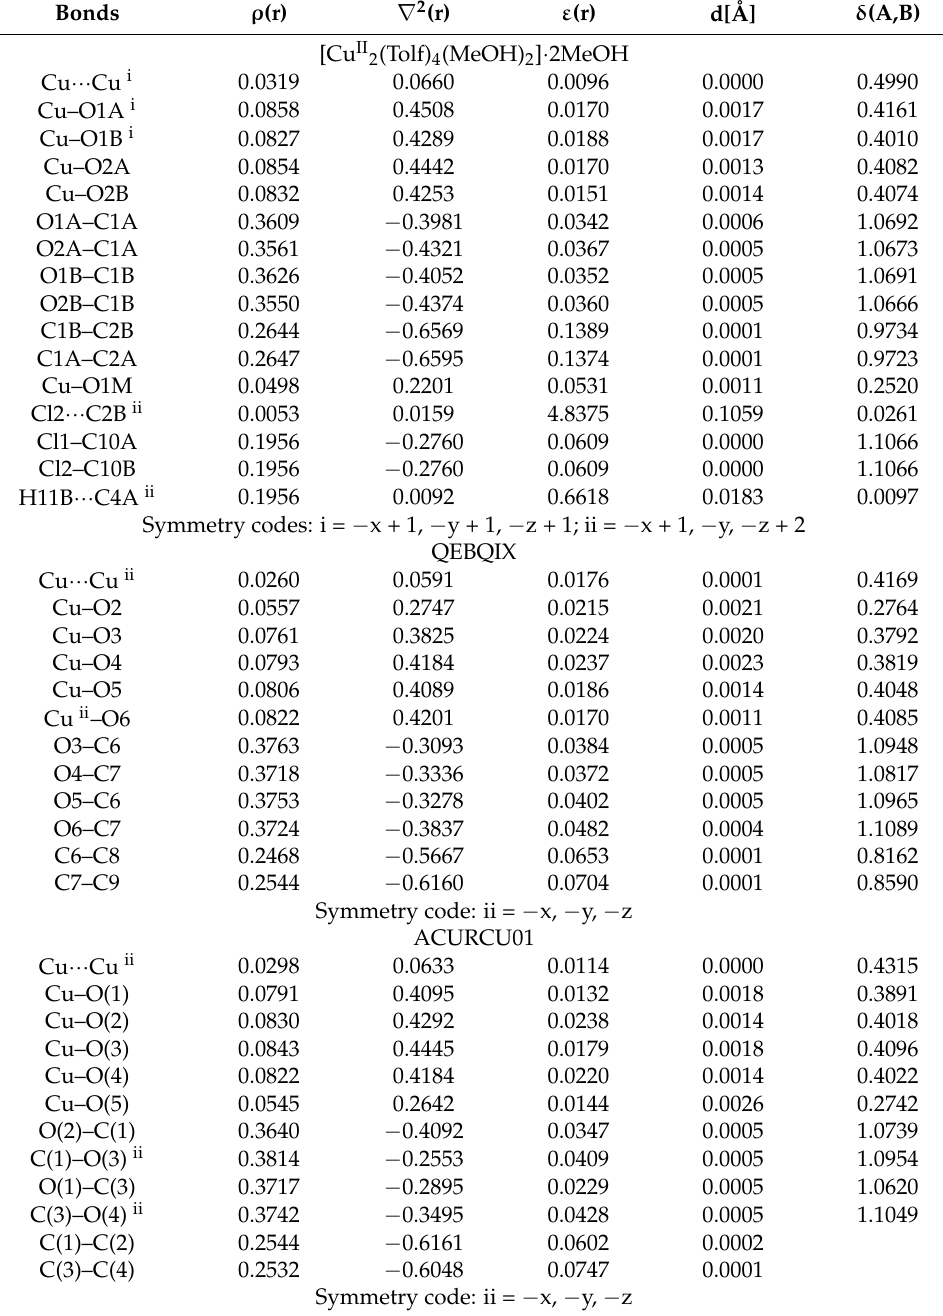
Table 5. QTAIM parameters for the chemical bonds and intermolecular interactions